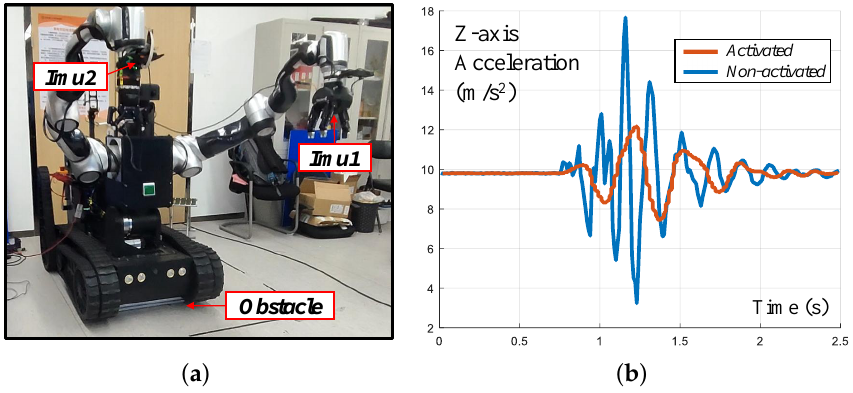
Figure 15. End-effector acceleration decline experiment. ( a ) Experiment setup. Two IMUs are mounted on both arms’end; ( b ) experiment result. About 50% of acceleration is reduced.